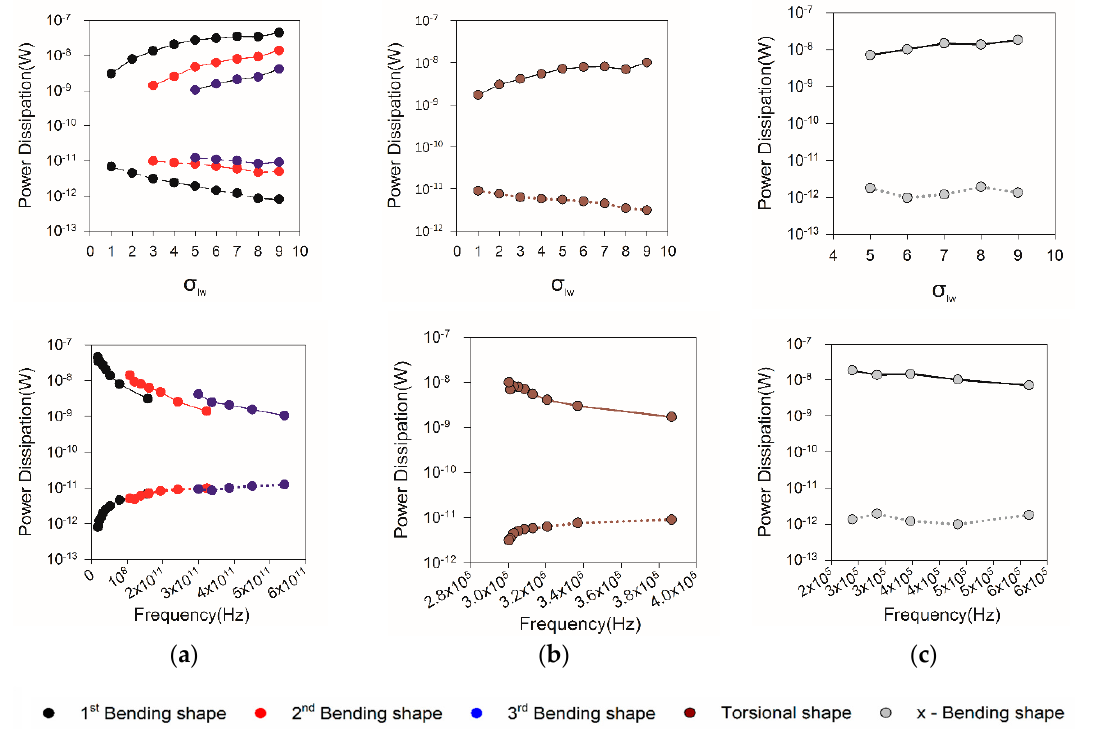
Figure 9. The power dissipation of conventional MCLs. ( a ) The power dissipation of MCLs in z -Bending vibration mode, ( b ) The power dissipation of MCLs in torsional vibration mode, ( c ) The power dissipation of MCLs in x -Bending vibration mode.